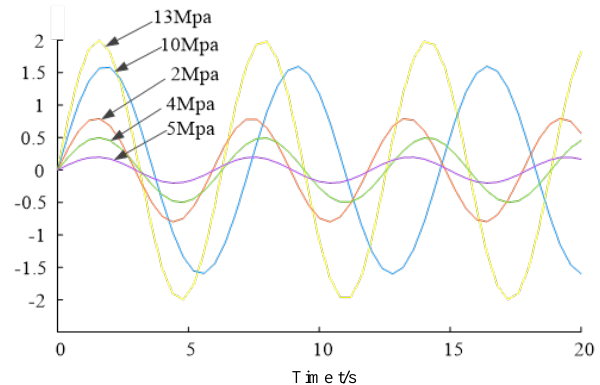
Figure 12. Simulated pressure output curve of accumulator under different inflation pressure.